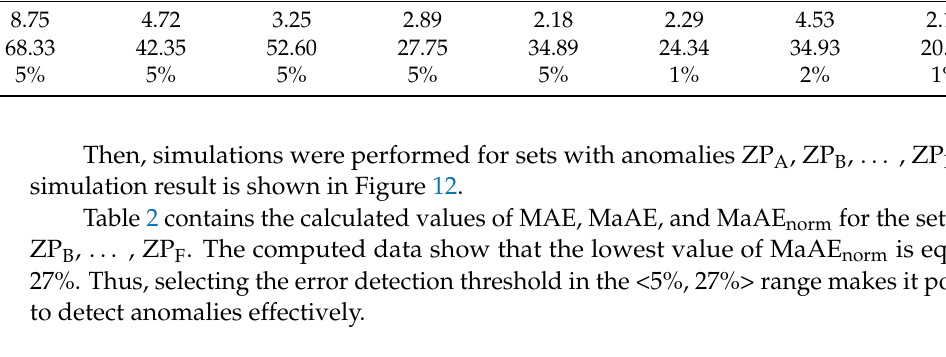
Table 2. Simulation results with the SARIMA algorithm for datasets ZP A , . . . , ZP F